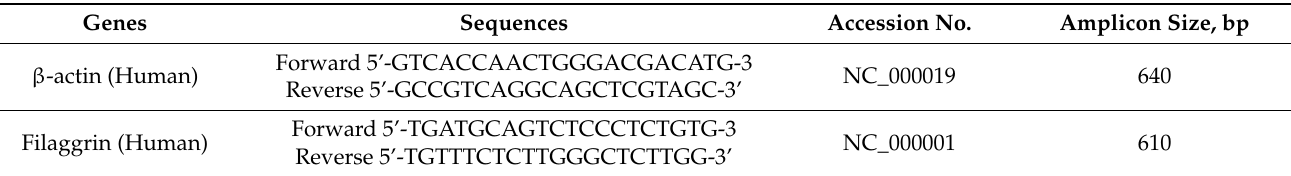
Table 1. RT-PCR primers used in the filaggrin